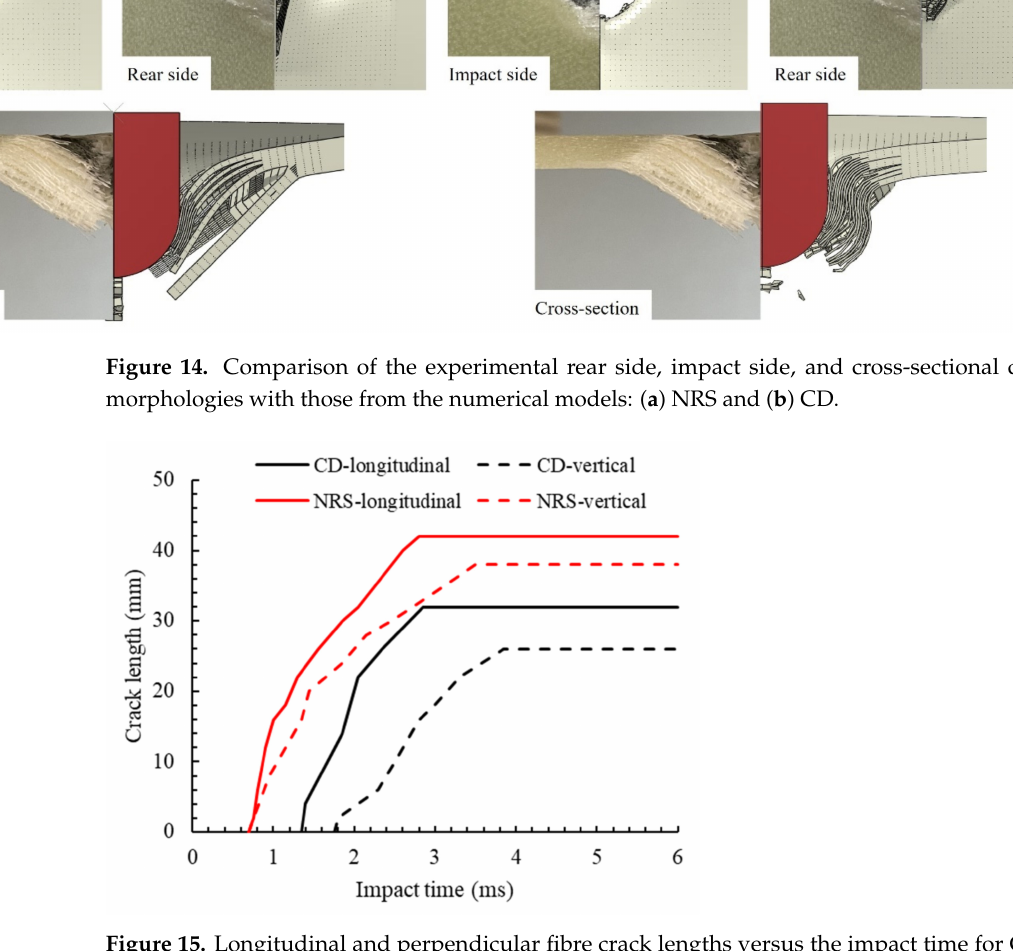
Figure 15. Longitudinal and perpendicular fibre crack lengths versus the impact time for CD and NRS